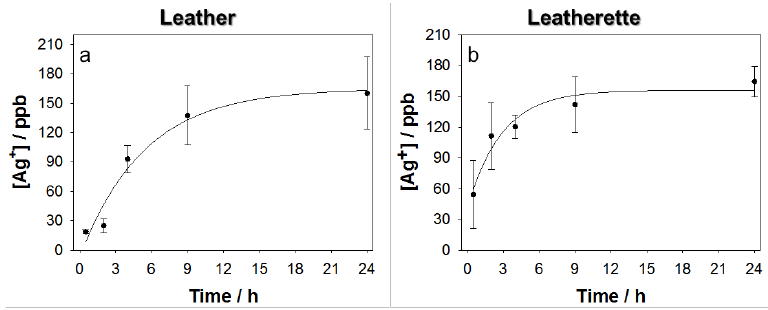
Figure 6. Silver ion release kinetics from Ag-treated leather ( a ) and leatherette ( b ).